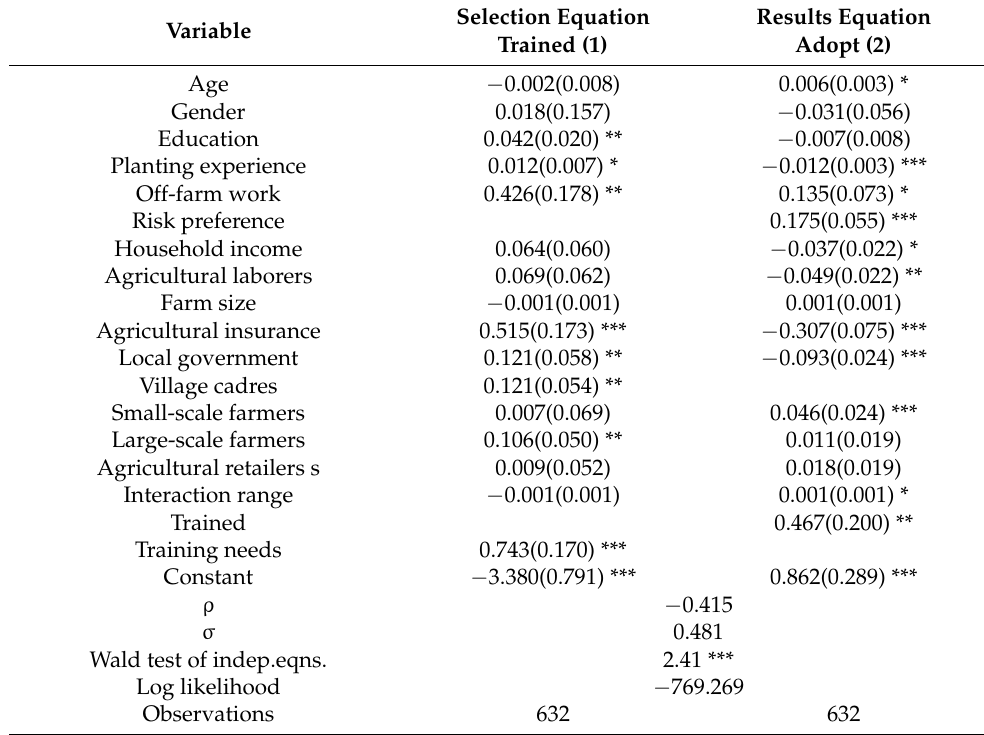
Table 9. The results of the treatment effect model (TEM).